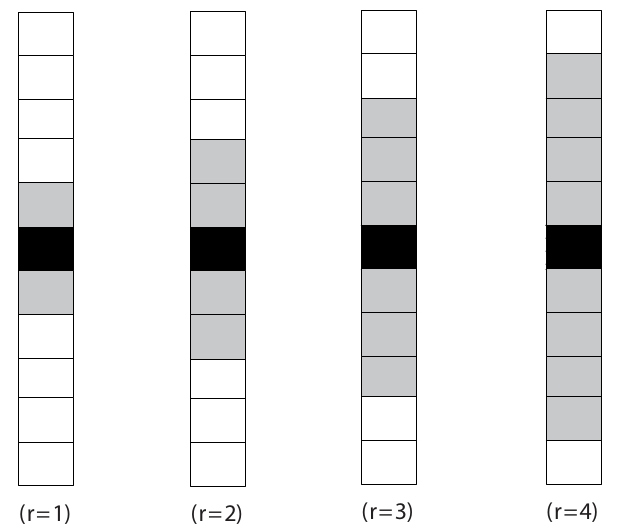
Figure 1. One-dimensional cellular automata grids based on the von Neumann neighbourhood concept. How many neighbours (grey cells) interact with an active cell (black) is controlled by the indicial radius ( r)